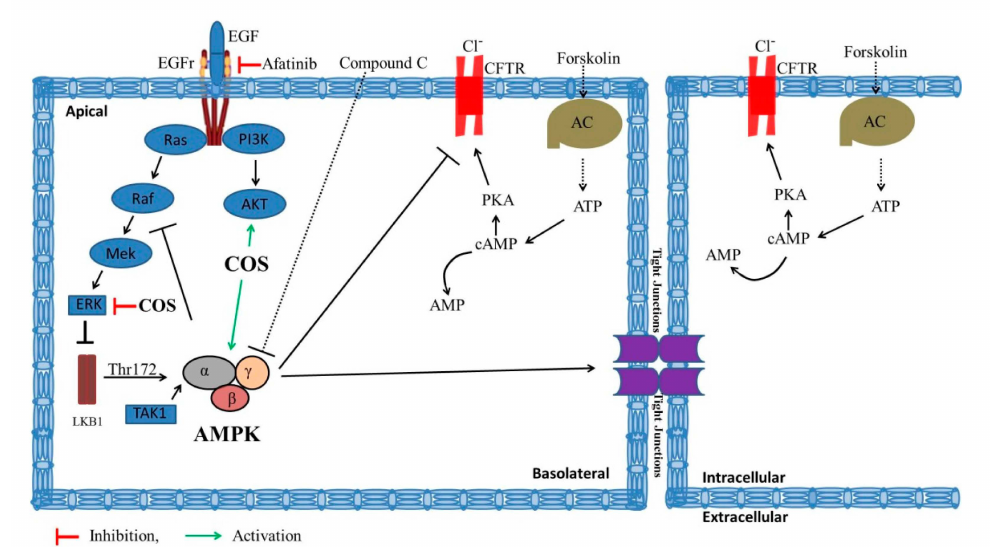
Figure 7. A schematic model summarizing the effect of COS against afatinib-induced intestinal barrier dysfunctions by modulating AMPK, PI3K/AKT, and MAPK/ERK